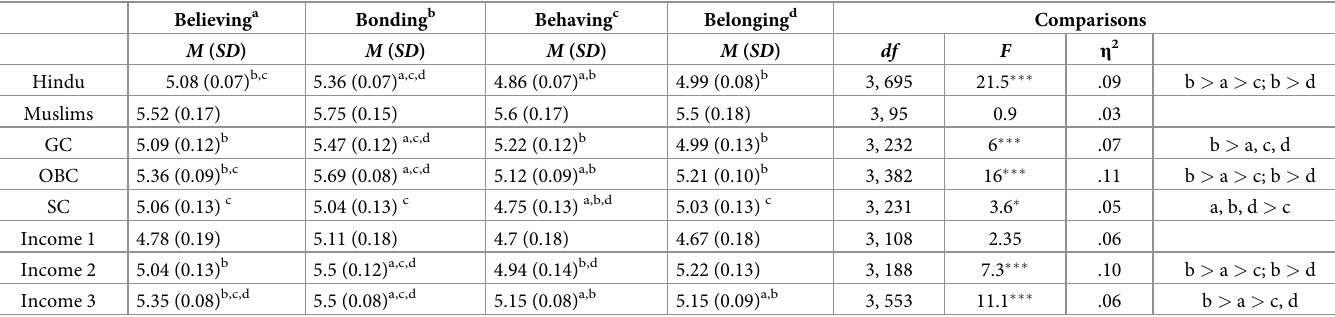
Table 9. The distribution and the comparison of the dimensions of religiousness in different groups among the students sample. Believing a Bonding b